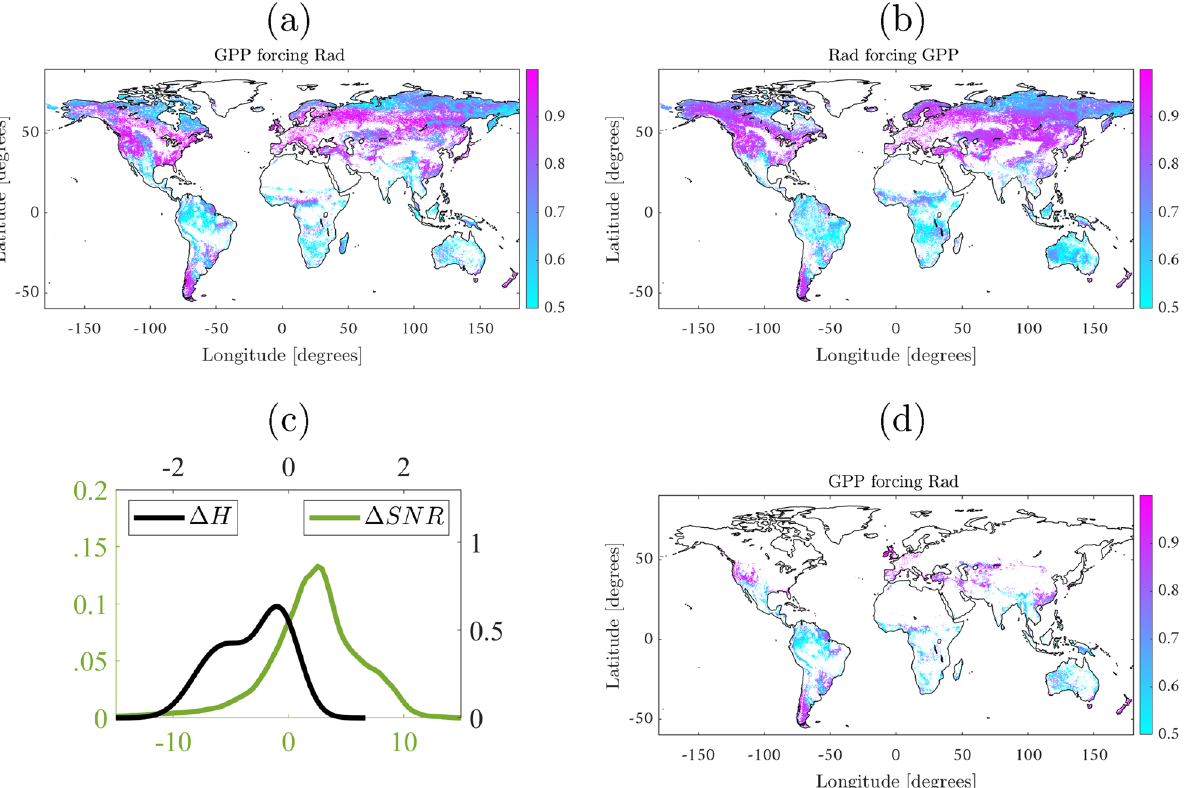
Figure 2. Top: ( a ) A significant and unrealistic widespread forcing of GPP over radiation is found by the CCM due to the strong immediate forcing of ( b ) radiation over GPP. Bottom: Signal-to-noise ( (cid:31) SNR) [dB] and entropy ( (cid:31) H) differences between GPP and radiation ( c ). The proposed methodology corrects CCM by taking into account entropy differences, and hence the estimated areas of forcing of GPP over radiation are reduced significantly ( d ). The figure was generated using Matlab version R2018a (https:// es. mathw orks.